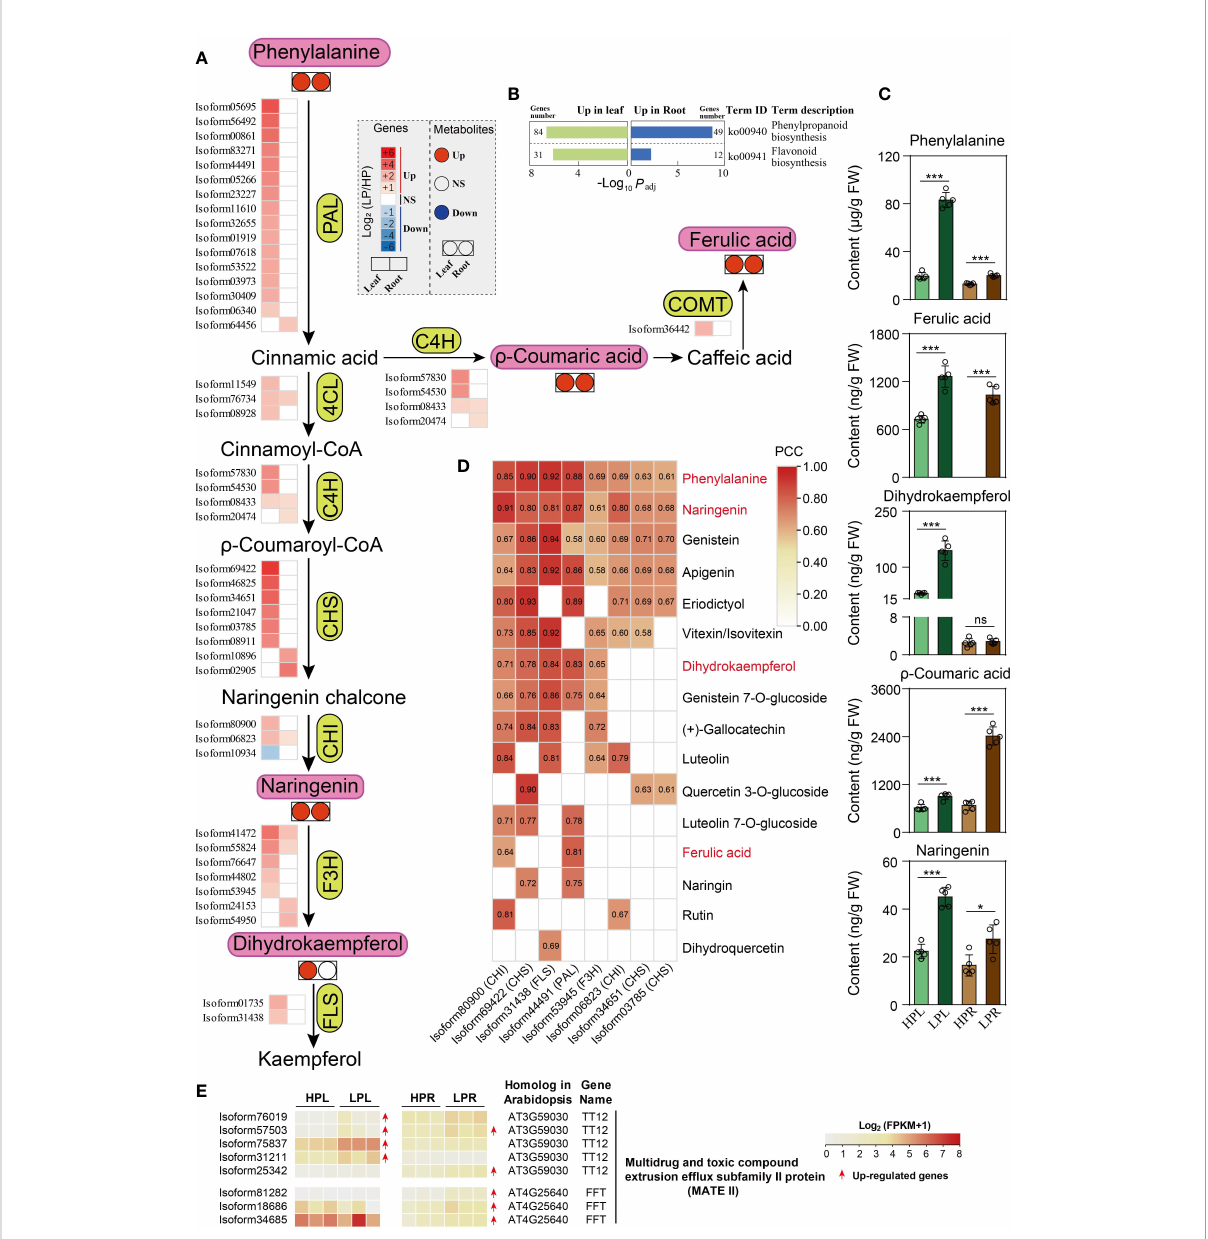
FIGURE 7 Phenylpropanoids and fl avonoids metabolism in response to Pi de fi ciency in elephant grass leaves and roots. (A, C) Changes in the expression levels of critical unigenes (A) and the contents of fi ve metabolites (C) in leaves and roots. (B) The signi fi cantly enriched KEGG pathways associated with DEGs of phenylpropanoid and fl avonoid metabolism. (D) Signi fi cantly positive correlation between unigenes and metabolites ( P < 0.05). (E) DEGs encoding multidrug and toxic compound extrusion ef fl ux subfamily II (MATE II) proteins in leaves and roots of elephant grass under Pi starvation. PAL, phenylalanine ammonia-lyase; C4H, trans-cinnamate 4-monooxygenase; COMT, fl avone 3 ′ -O-methyltransferase; 4CL, 4-coumarate-CoA ligase 3; CHS, chalcone synthase; CHI, chalcone- fl avanone isomerase; F3H, naringenin,2-oxoglutarate 3-dioxygenase; FLS, fl avonol synthase/ fl avanone 3-hydroxylase. Asterisks in (C) indicate signi fi cant differences using the Student ’ s t-test (*: 0.01 < P < 0.05, ***: P < 0.001), ns indicate non-signi fi cant differences ( P >